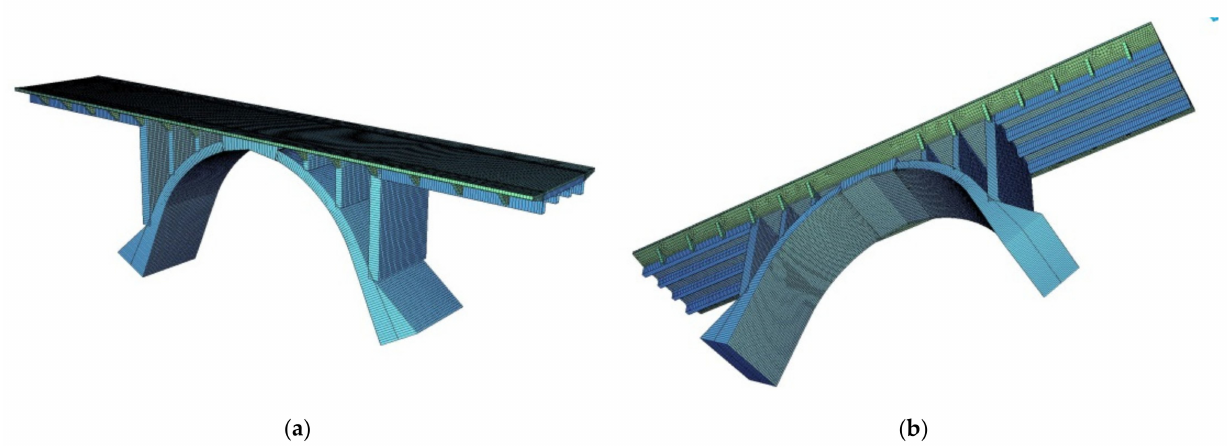
Figure 7. FEM model: ( a , b ) 3 D views.